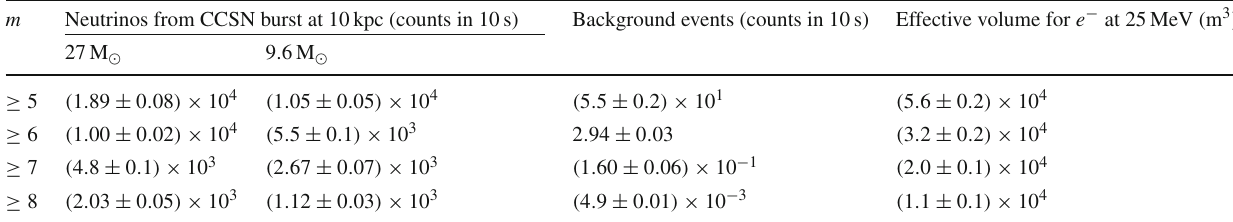
Table 3 Number of signal and background events and effective volume for different m (see trigger conditions in Sect. 4; Δ t coin = 20ns, Δ T = 10s), for a detector with 10,000 mDOMs SN m Neutrinos from CCSN burst at 10kpc (counts in 10s) Background events (counts in 10s) Effective volume for e − at 25MeV (m 3 )